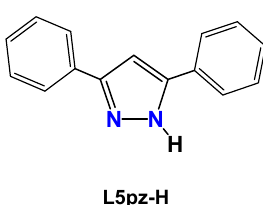
Complex Complex